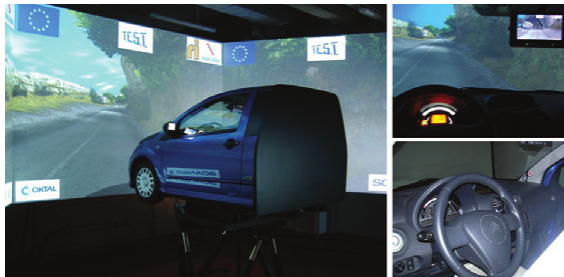
Table 1. Kinematic limits of the motion system Translation Longitudinal Lateral Vertical –247/+248